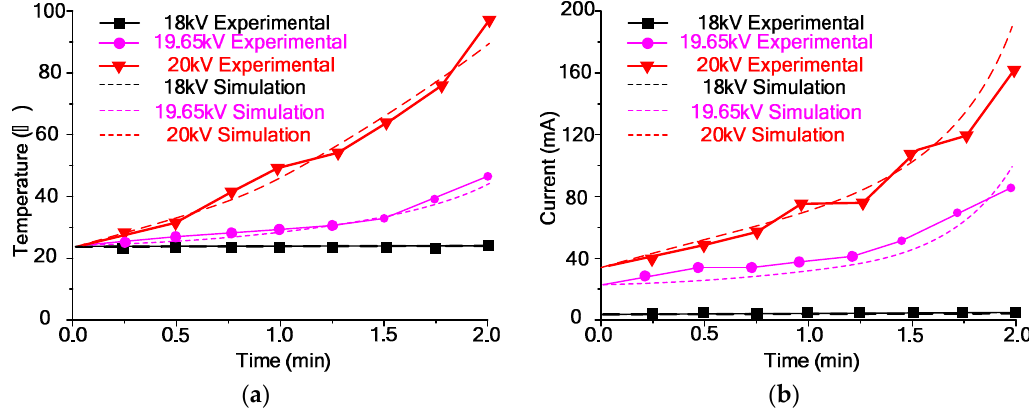
Figure 12. Amplitudes’ variation of temperature and leakage current with time. ( a ) Temperature; ( b ) leakage current.